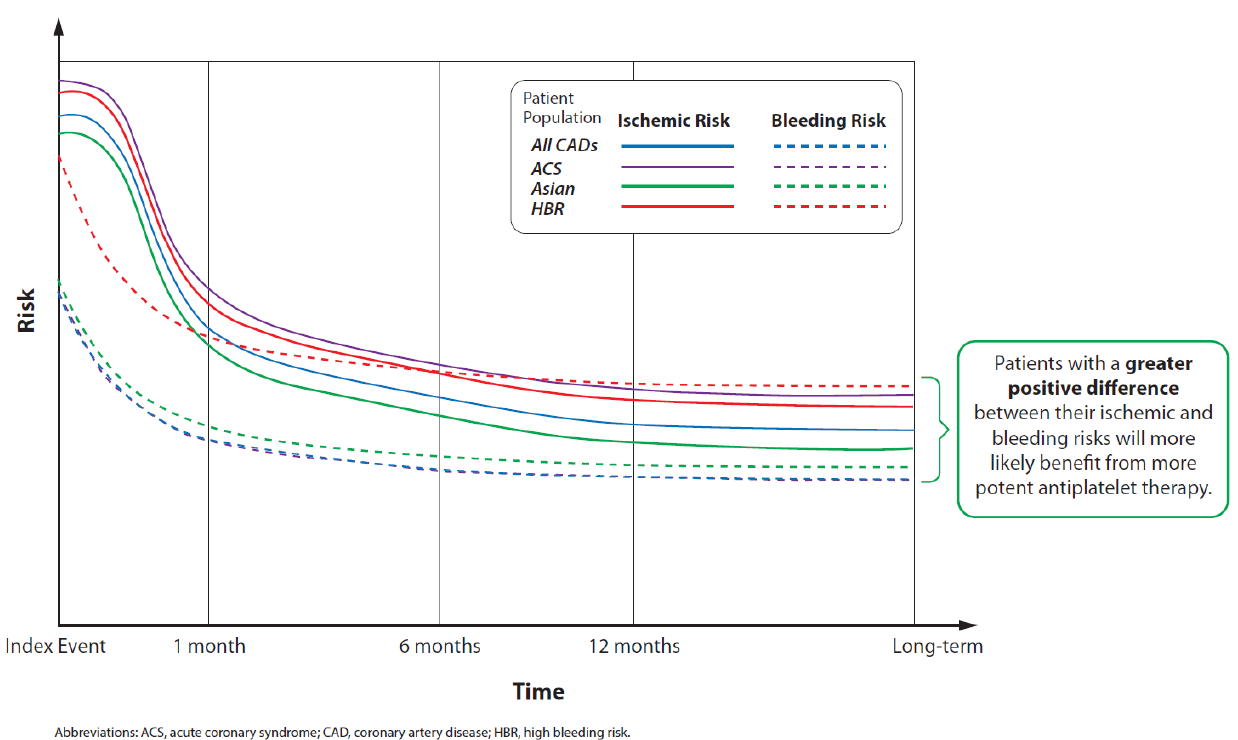
Figure 2. Schematic representation of usual changes in ischemic and bleeding risks over time (from an index time point) for several different populations, relative to all CAD patients (reference group). Note that the patient populations may